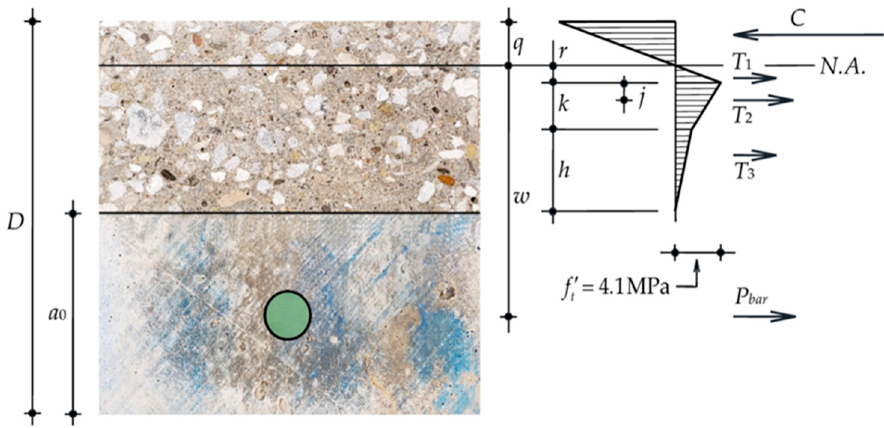
Figure 14. A typical cross-section analysis for PN_B_X series.